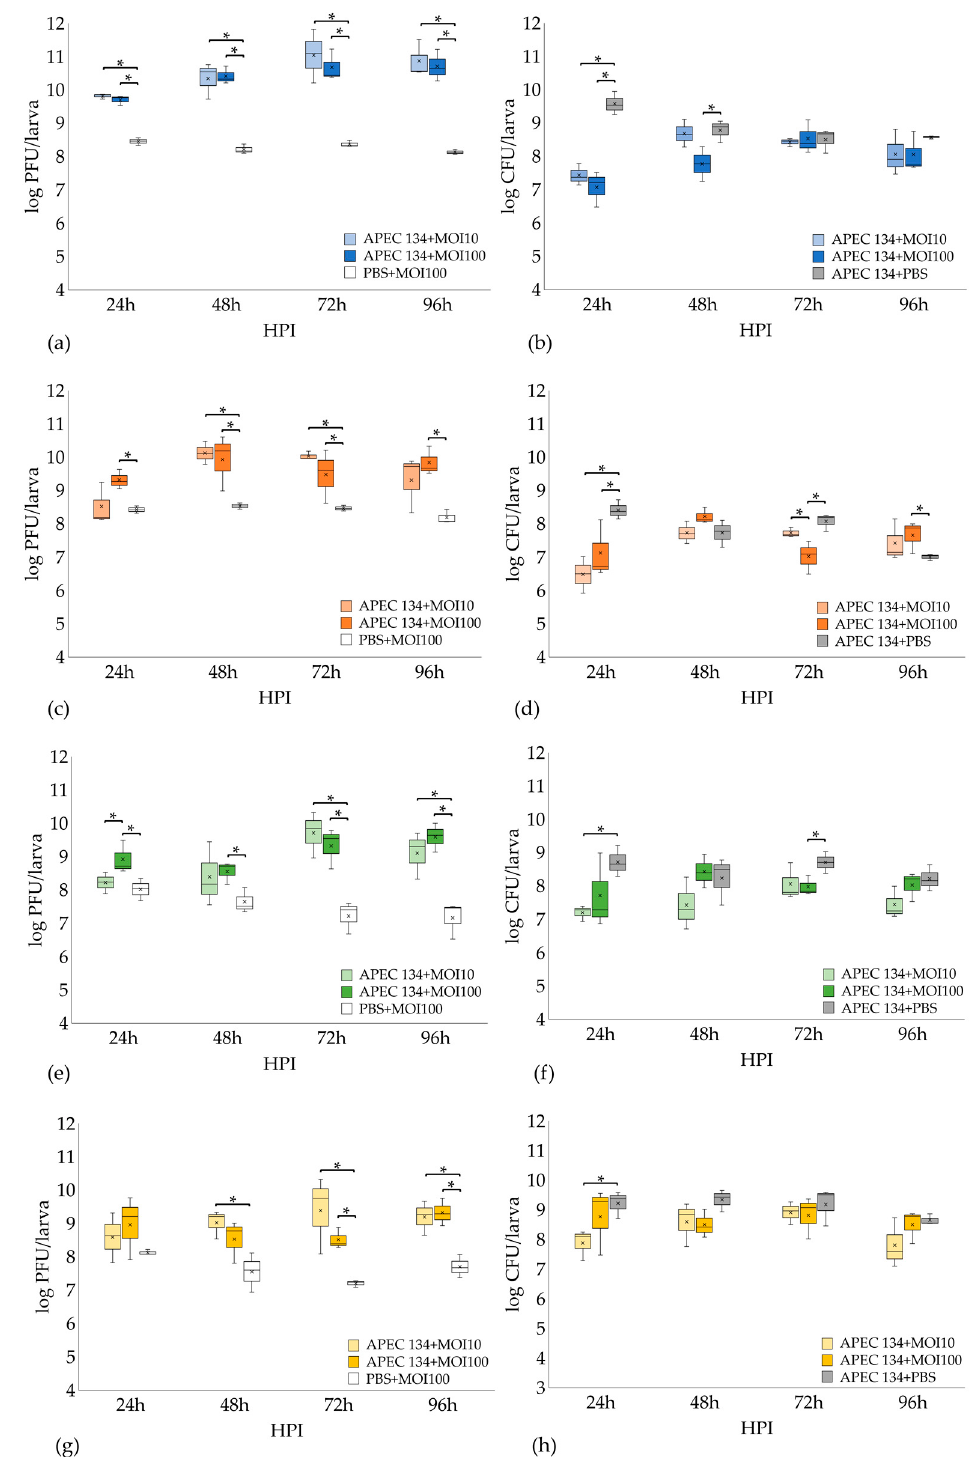
Figure 10. Phage vB_EcoS_K1-ULINTec2 ( a ), vB_EcoP_K1-ULINTec4 ( c ), vB_EcoP_K1-ULINTec6 ( e ), vB_EcoP_K1-ULINTec7 ( g ), and bacterial vB_EcoS_K1-ULINTec2 ( b ), vB_EcoP_K1-ULINTec4 ( d ), vB_EcoP_K1-ULINTec6 ( f ), and vB_EcoP_K1-ULINTec7 ( h ) concentrations measured during the titration experiments using the G. mellonella model. Titrations were performed every 24 h for 96 h. The results present data from 3 independent experiments. p -value (*) < 0.05. MOI: multiplicity of infection. HPI: hours post inoculation.